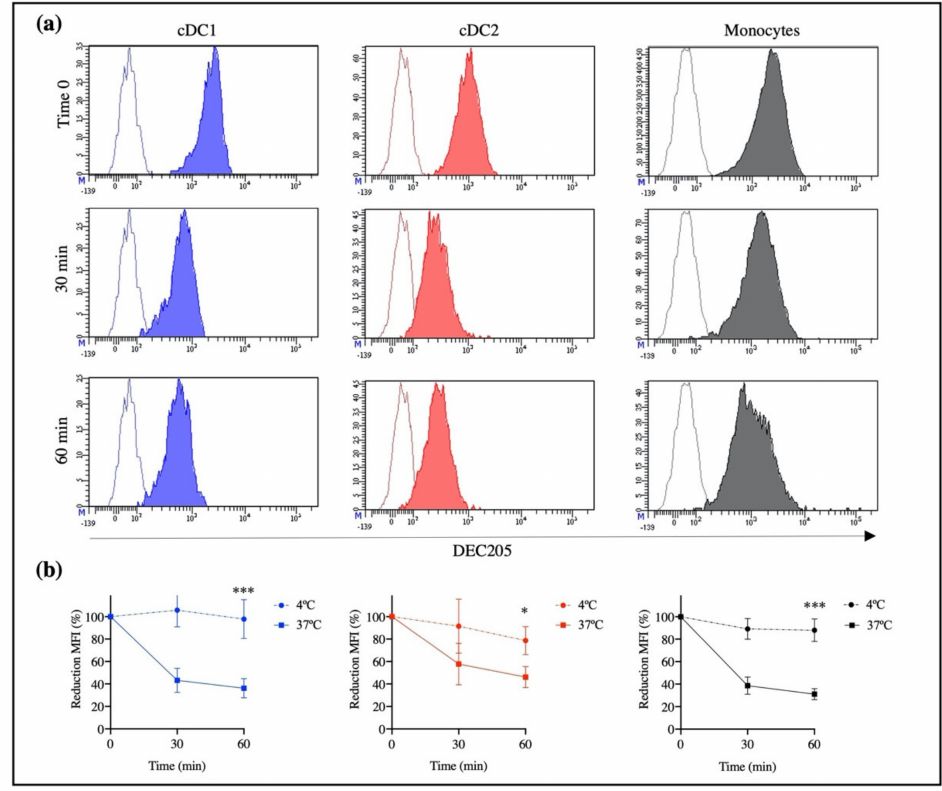
Figure 3. Identification of cDC1, cDC2, and DEC205 + monocytes by rAb ZH9F7-Cap and receptor- mediated internalization. DEC205 surface expression in cDC1, cDC2, and monocytes after 30 and 60 min of incubation with rAb ZH9F7 at 37 ◦ C. ( a ) Contour histograms represent FMO, while colored histograms represent the expression of DEC205 on cDC1 (blue), cDC2 (red), and monocytes (gray). ( b ) Percentage of mean fluorescence intensity (MFI) after incubation at 37 ◦ C and 4 ◦ C by cDC1 (blue), cDC2 (red), and monocytes (black). Dots represent the mean ± SD of reduction in MFI on cells obtained from 3 pigs. Asterisks denote statistically significant differences between MFI after incubation at 37 ◦ C and 4 ◦ C for 1 h (*** p < 0.0005; * p <